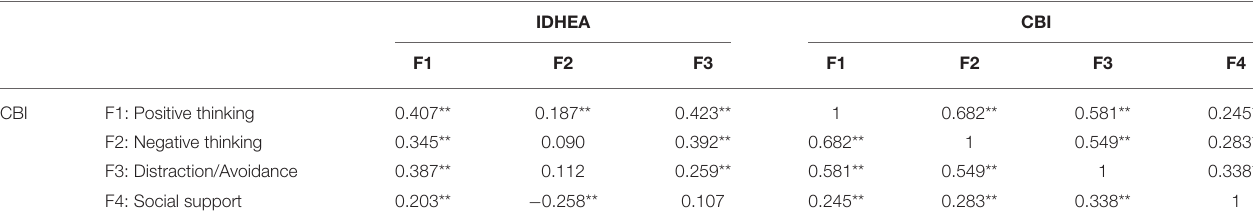
TABLE 3 | Correlations between CBI and IDHEA.